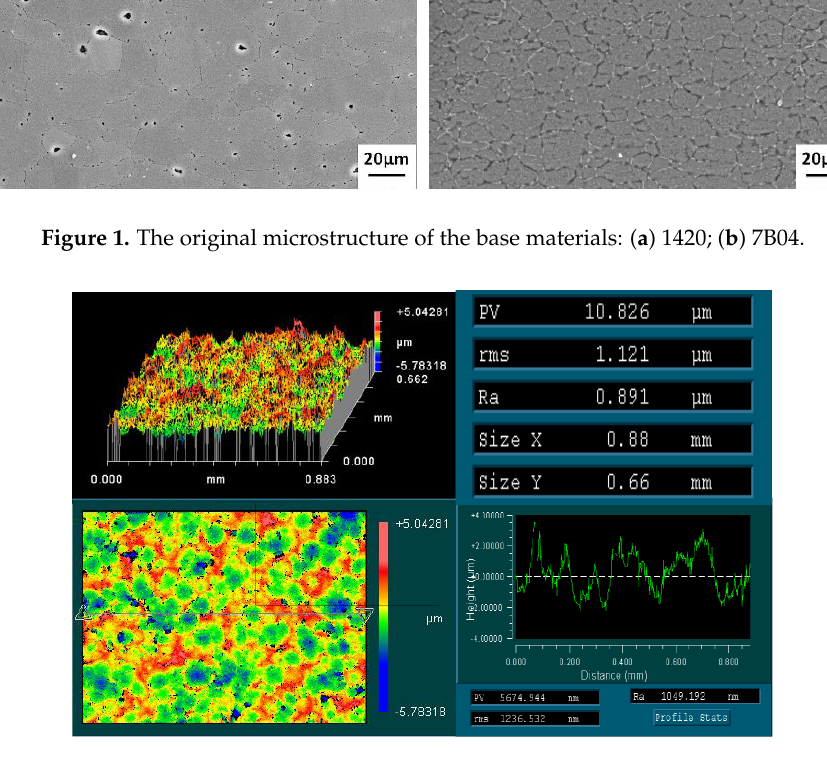
Table 1. Chemical composition of parent metals (wt.%). Alloys